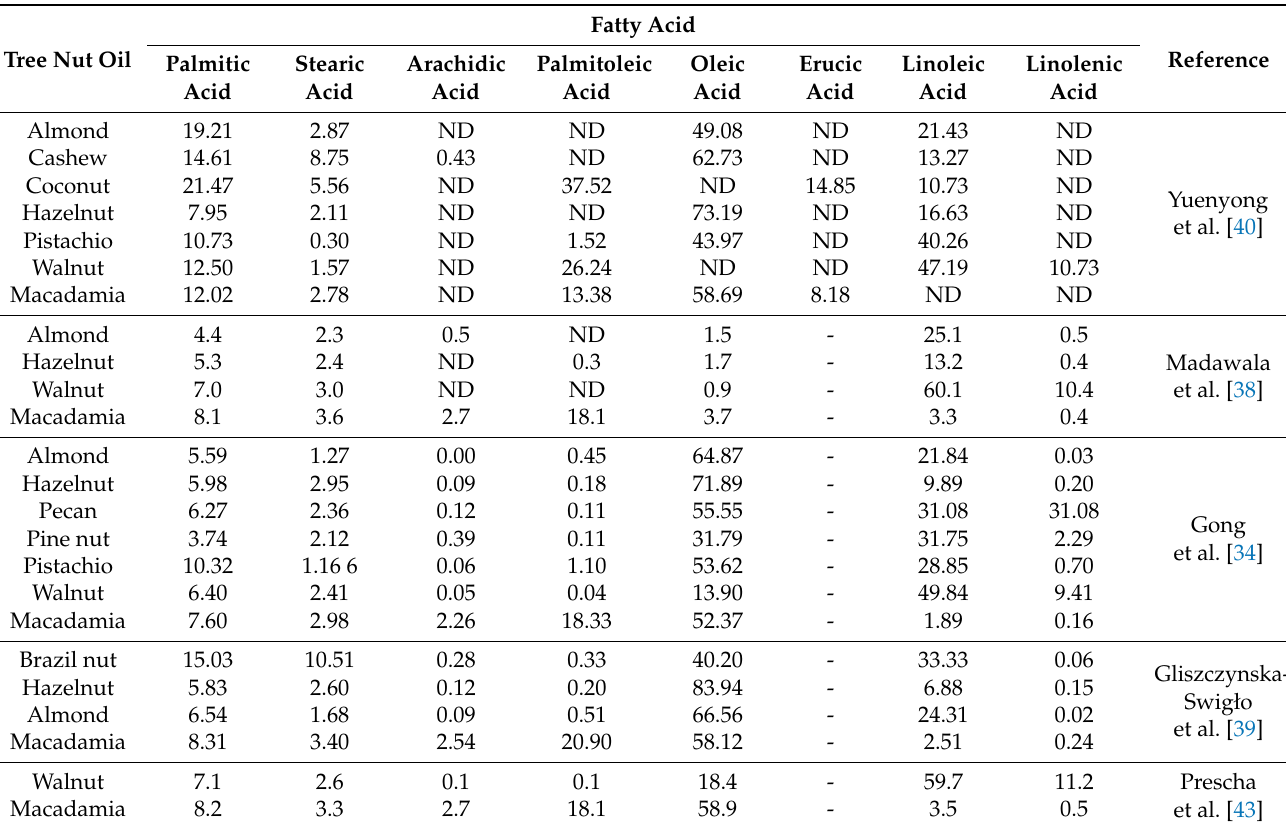
Table 2. Comparison of fatty acid composition (%) of cold-pressed macadamia nut oil with cold- pressed oil from selected tree